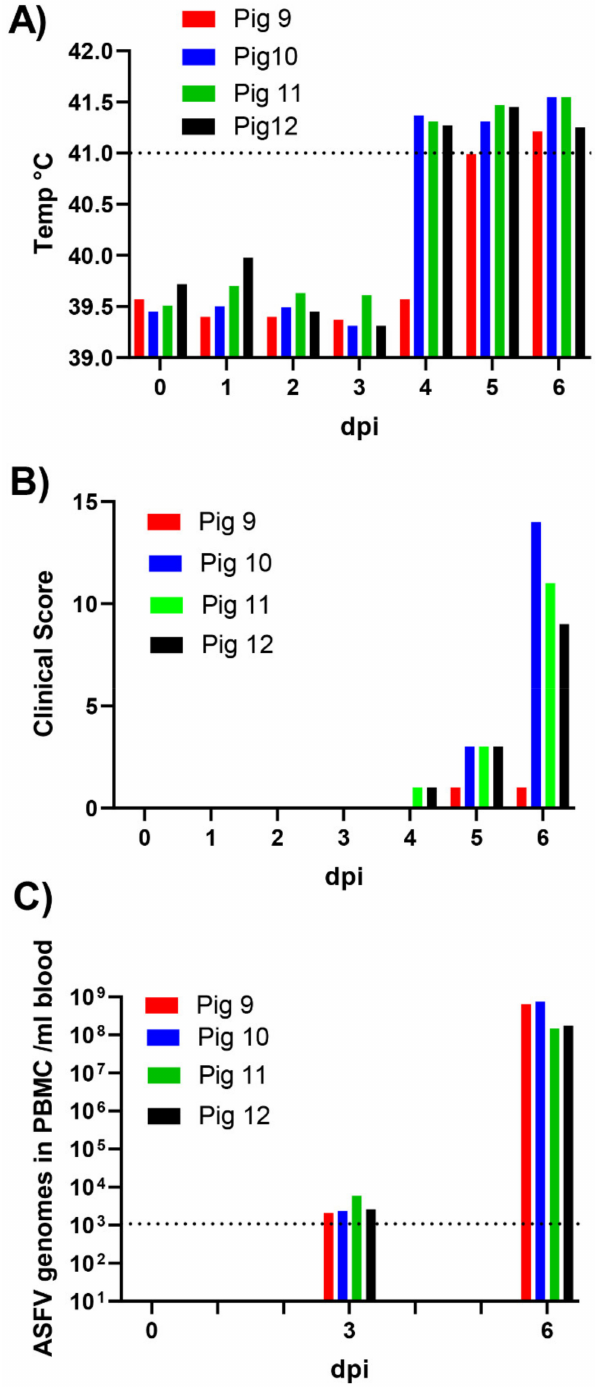
Figure 1. Time course of infection of pigs with ASFV. Pigs were inoculated intranasally with ASFV/POL/2015/Podlaskie at 0 dpi, and then their rectal temperatures were taken on a daily basis ( A ) and clinical signs of disease (for 8 parameters) were also scored ( B ). Blood samples were collected at 0 dpi (prior to inoculation), at 3 dpi and at 6 dpi; the animals were euthanized at 6 dpi. PBMCs were purified from the blood samples (4 mL). The presence of ASFV DNA in the PBMCs ( C ) was quantified by qPCR and values converted to gene copy numbers/mL blood by reference to a standard curve. Levels below 10 3 ASFV genomes/mL (indicated by dashed line) were outside of the linear range of the